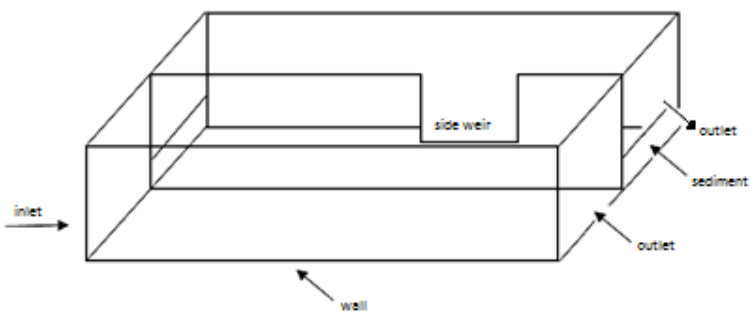
Figure2. scheme for computational domain and boundary